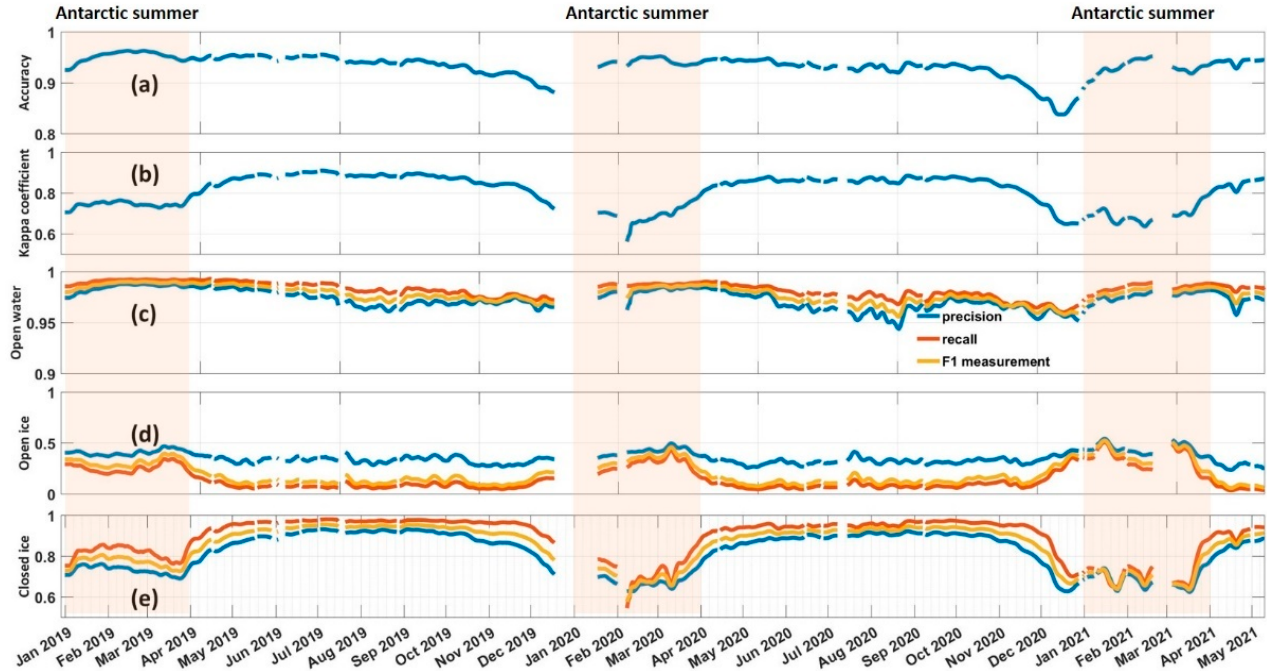
Figure 8. The time series of the evaluation parameters of the sea ice monitoring training model in the Arctic from 1 January 2019 through 10 May 2021 for ( a ) the overall accuracy, ( b ) kappa coefficient, ( c ) open water, ( d ) open ice, and ( e ) closed ice, respectively.